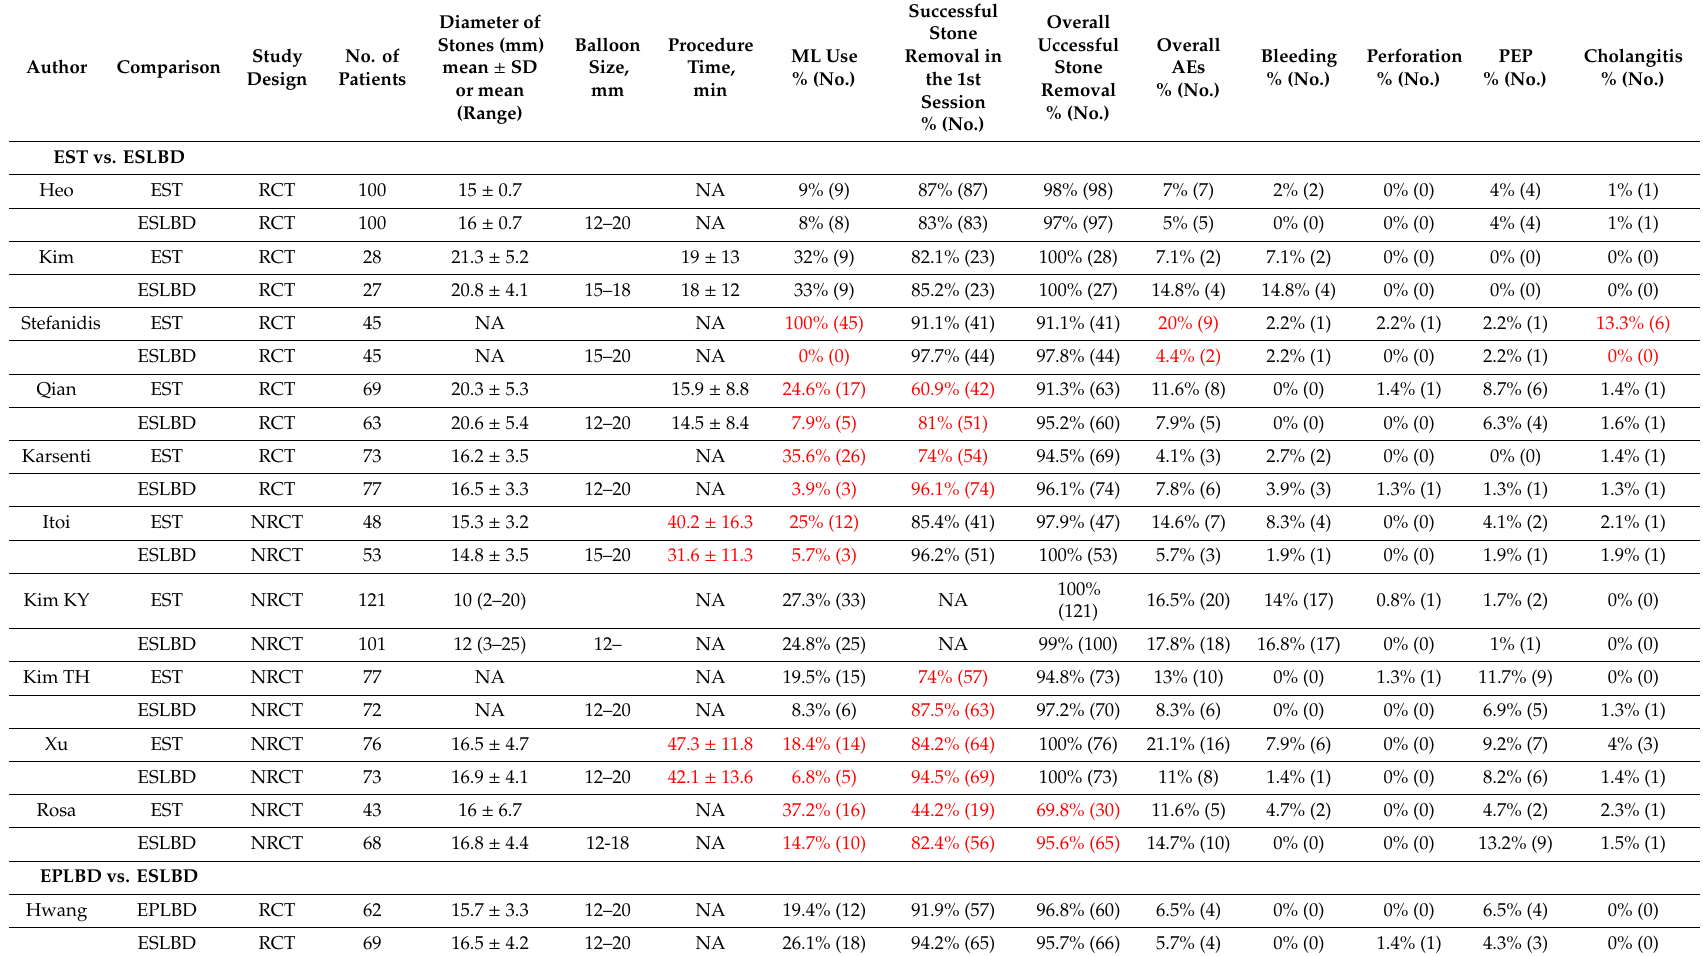
Table 3. Baseline characteristics, procedural outcomes and adverse events of the included studies for large common bile dust